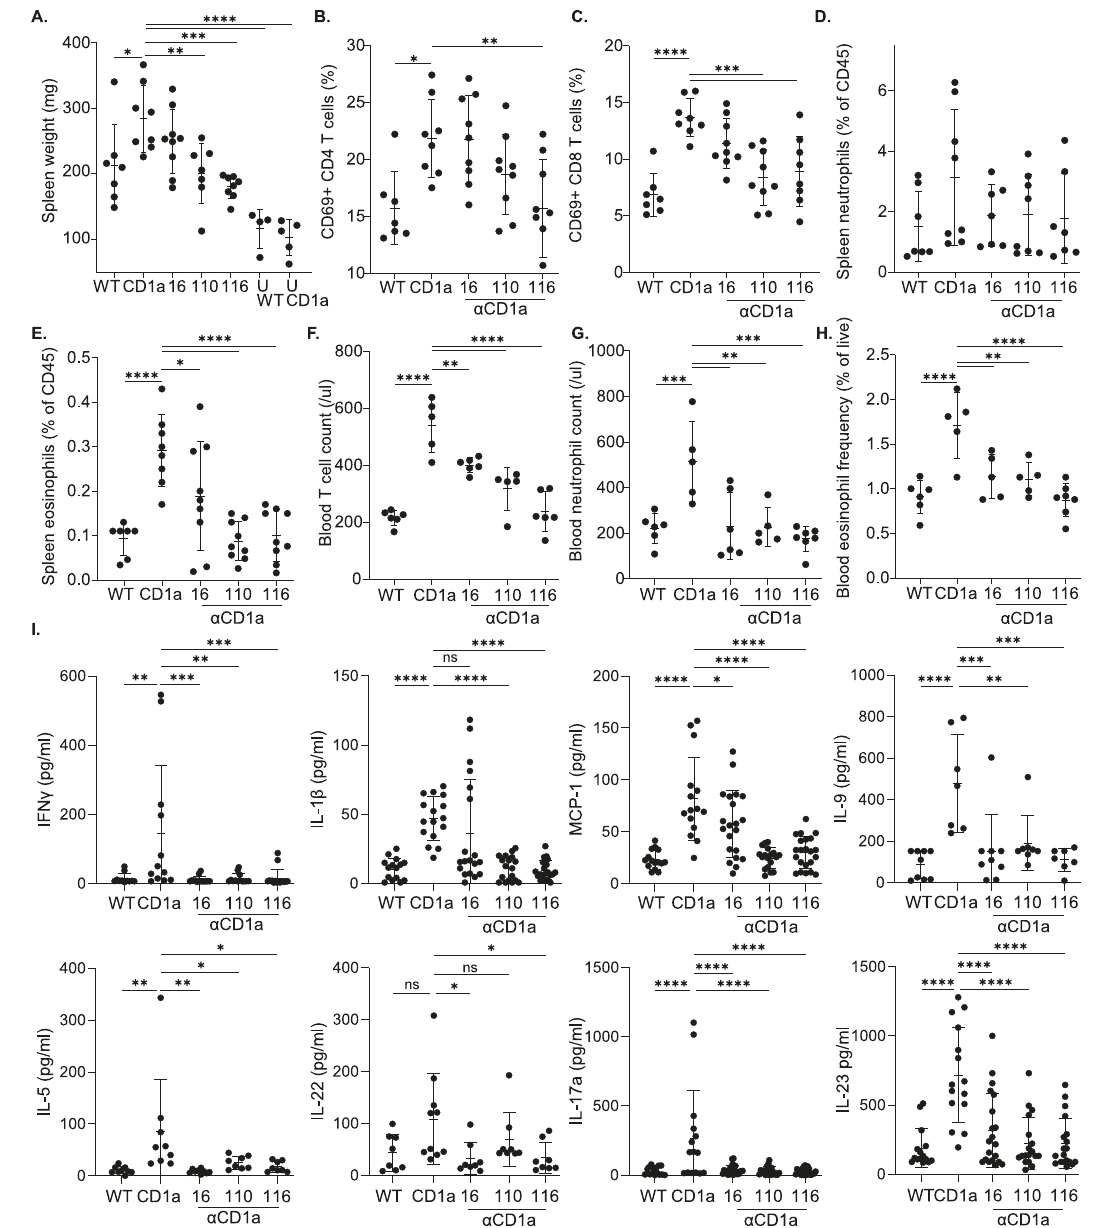
Fig. 7 | Investigation of the CD1a dependency of the systemic effects of imi- quimodapplication.A Spleenweight(mg)measurementsonday8byimiquimod treatment of wild-type (WT) and CD1a transgenic mice (CD1a) followed by treat- ment i.p. with mouse IgG1 isotype control or CD1a transgenic injected with the re fi ned panel of anti-CD1a antibodies as in the schematic (Fig. 6A). B – E Flow cytometric analysis of spleen of mouse IgG1 isotype treated wild-type (WT) and CD1atransgenic(CD1a);andCD1atransgenicinjectedwiththere fi nedpanelofanti- CD1a antibodies following the treatment model of administration. Splenic CD4 ( B ) and CD8 ( C ) T-cell CD69 expression was assessed and neutrophils ( D ) and eosi- nophils ( E ) were enumerated. F – H Blood cellular analysis of the blood of mouse IgG1 isotype treated wild-type (WT) and CD1a transgenic (CD1a); and